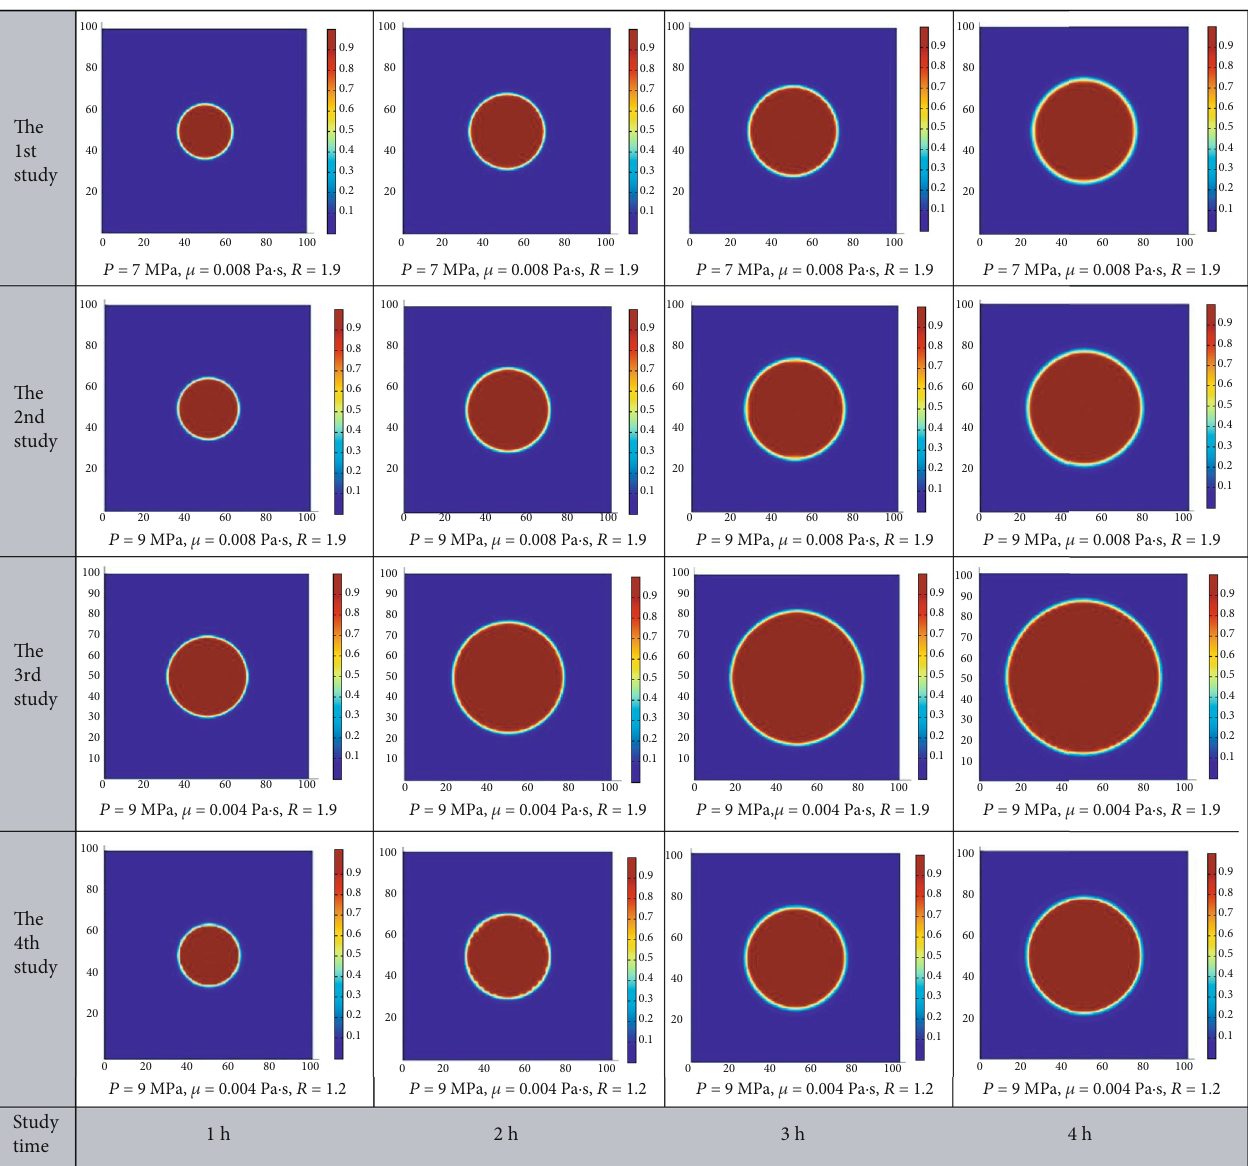
Figure 6: The distribution plot of slurry di ff usion at di ff erent situation with